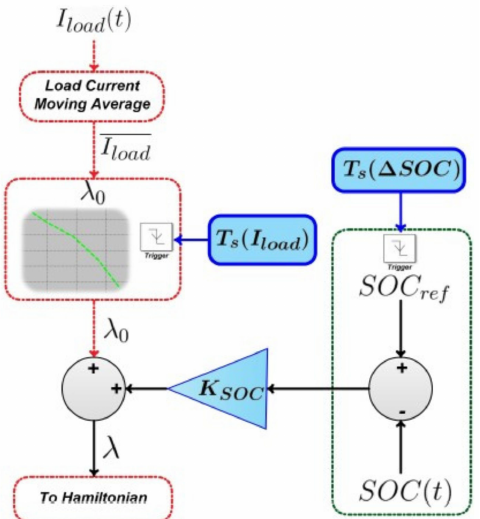
Figure 6. Flowchart for adaptive PMP algorithm